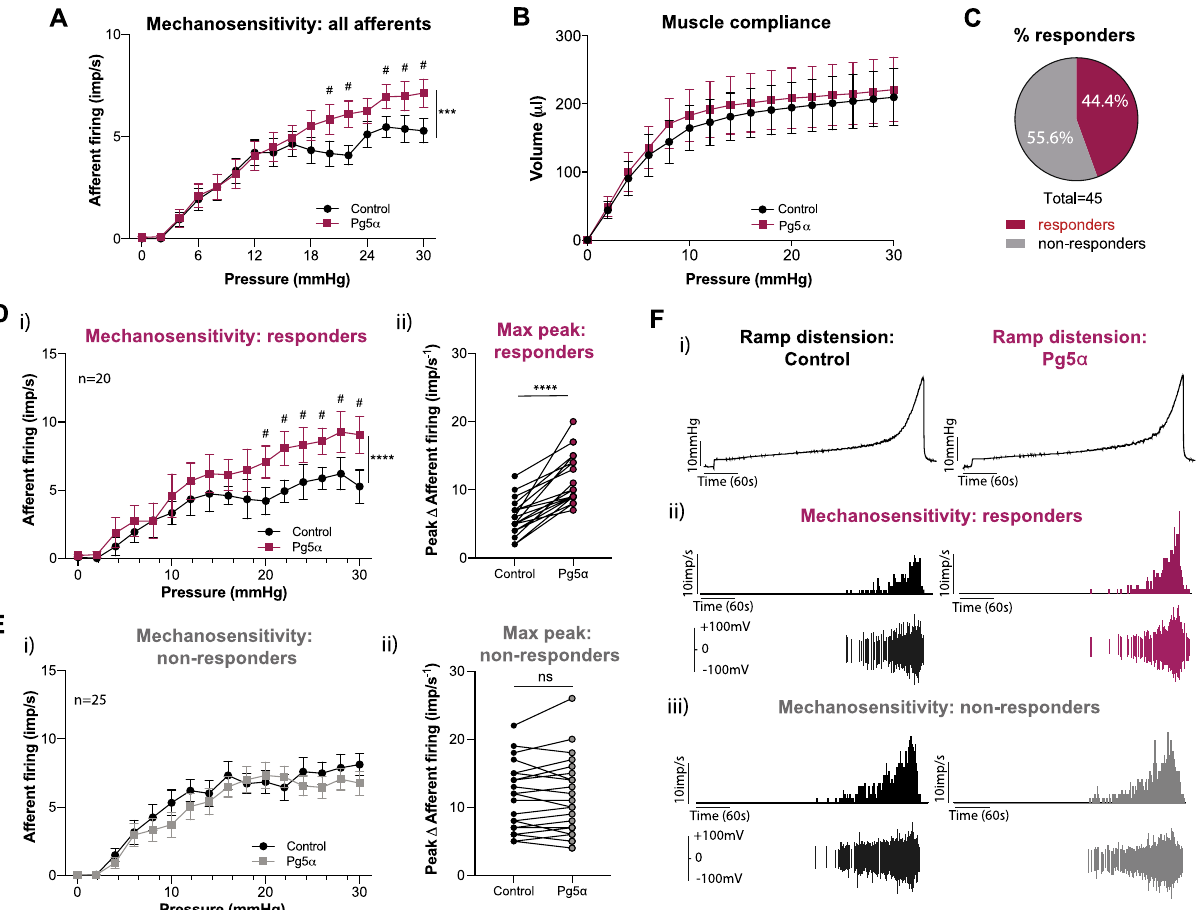
Figure 1. Pg5α enhances bladder afferent responses to mechanical stimuli ex vivo. ( A ) Whole nerve afferent firing was measured in response to graded bladder distension in an ex vivo preparation in the presence of saline (control) or progesterone sulphate ‘5α-pregnan-3β-ol-20-one sulphate’ (Pg5α; 300 µM). Application of Pg5α increased the overall bladder afferent firing rate (impulses per second; imp/s) in response to bladder distension compared to saline (n = 45 single units from N = 5 mice; *** P < 0.001 and # P < 0.05 at individual distension pressures). ( B ) The intraluminal pressure measured as volume during bladder distension did not differ between saline and Pg5α (ns, P > 0.05), indicating no change in muscle compliance. ( C ) Of the 45 mechanosensitive bladder afferents recorded, 44.4% (20 out of 45) increased their responsiveness to distension following Pg5α (responders), whilst 55.6% (25 out of 45) were unchanged (non-responders). A single unit was deemed to be responsive if a greater than 20% increase in afferent responsiveness was detected. ( D ) Responding afferents had (i) significantly enhanced afferent firing rates at pressures of 20 mmHg and above ( # P < 0.05) and (ii) a significantly higher maximum peak in afferent firing in the presence of Pg5α compared to saline (**** P < 0.0001). ( E ) Non-responding mechanosensitive afferents had ( i ) no significant difference in afferent firing at any distension pressure and ( ii ) no significant difference in the maximum peak of afferent firing between distensions with saline or Pg5α ( ns , P > 0.05). F ) Representative examples demonstrating the ( i ) graded increase in pressure with volume over time in response to bladder distension, ( ii ) a Pg5α-responsive afferent during bladder distension in the presence of saline and Pg5α, and ( iii ) Pg5α non-responsive mechanosensitive afferent during bladder distension in the presence of saline and Pg5α. Data are represented as mean ± SEM ( A , B , Di , Ei ), or percentage of afferents ( C ), or maximum imp/s before and after Pg5α ( Dii , Eii ). ‘Responders’ were defined by a greater than 25% increase in afferent firing ( C , D , E , F ). P values are based on two-way ANOVA ( A , B , Di , Ei , with subsequent Sidak’s post hoc test significance at individual data points indicated ( A , Di , # represents significance of at least P < 0.05), or Wilcoxon matched-pairs signed rank test ( Dii , Eii